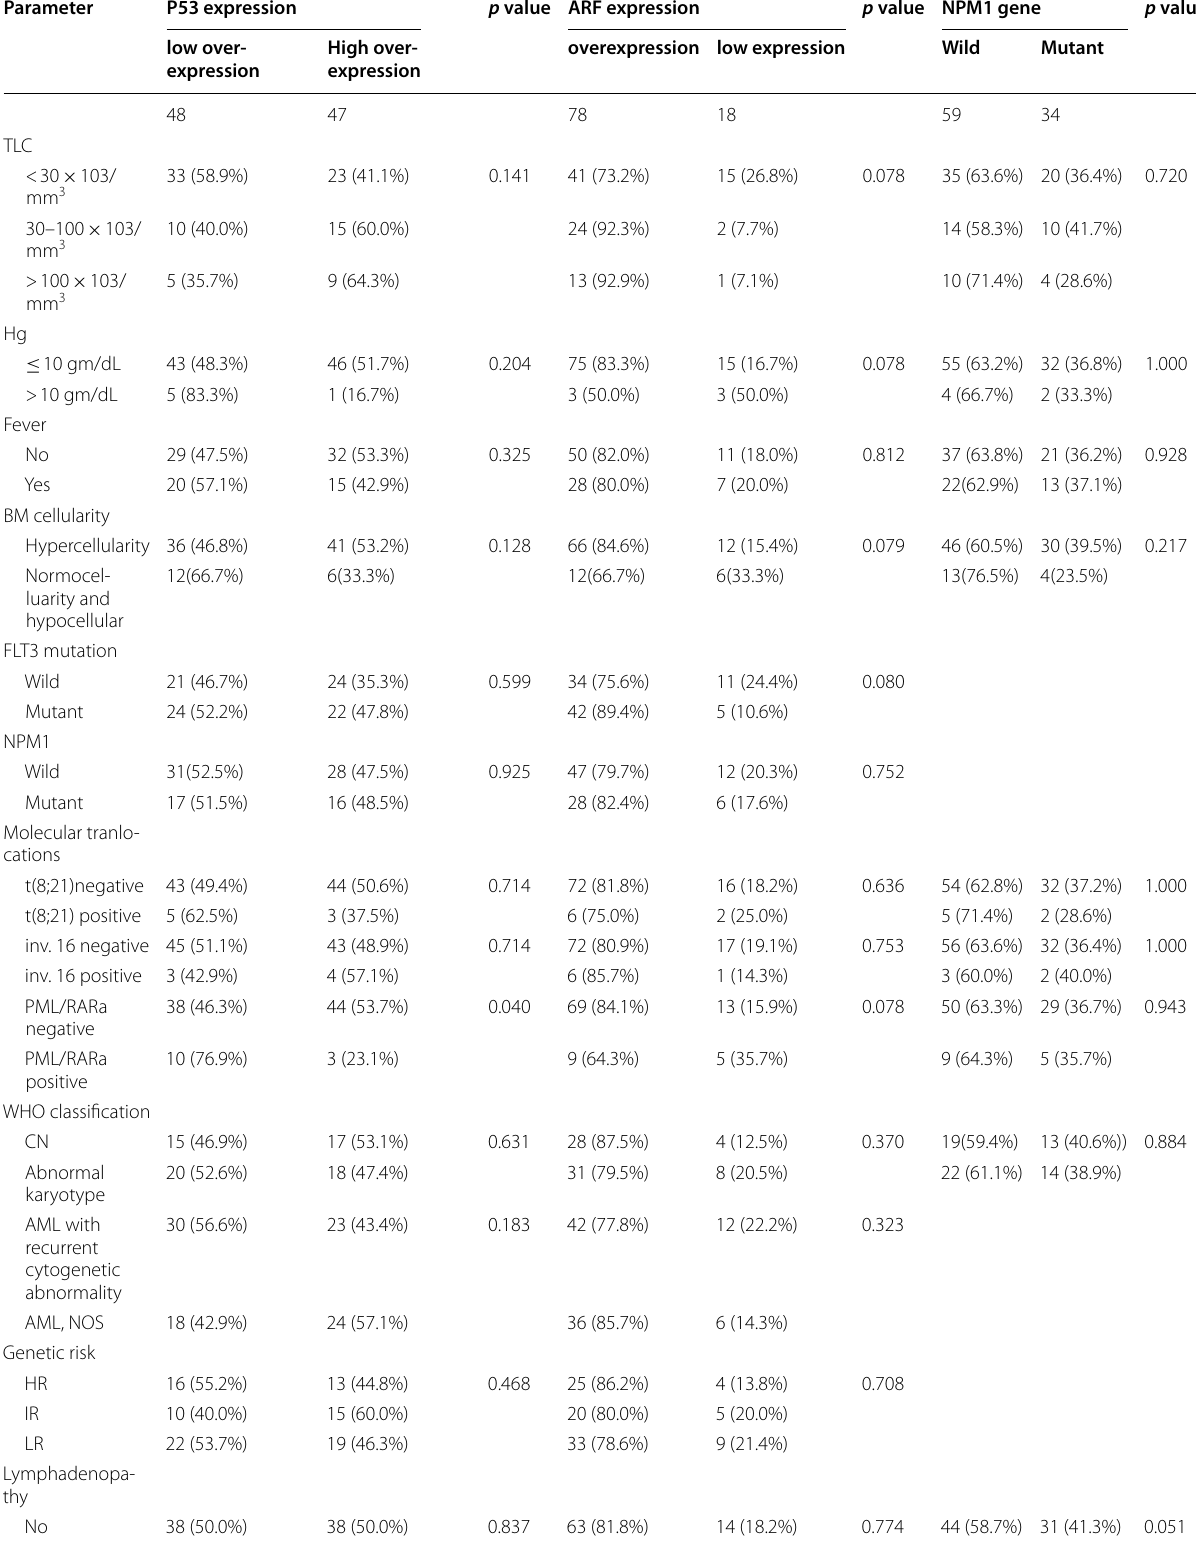
Table 4 Association between the expression of p53, ARF, and NPM1 genes with patients’ clinical and laboratory characteristics